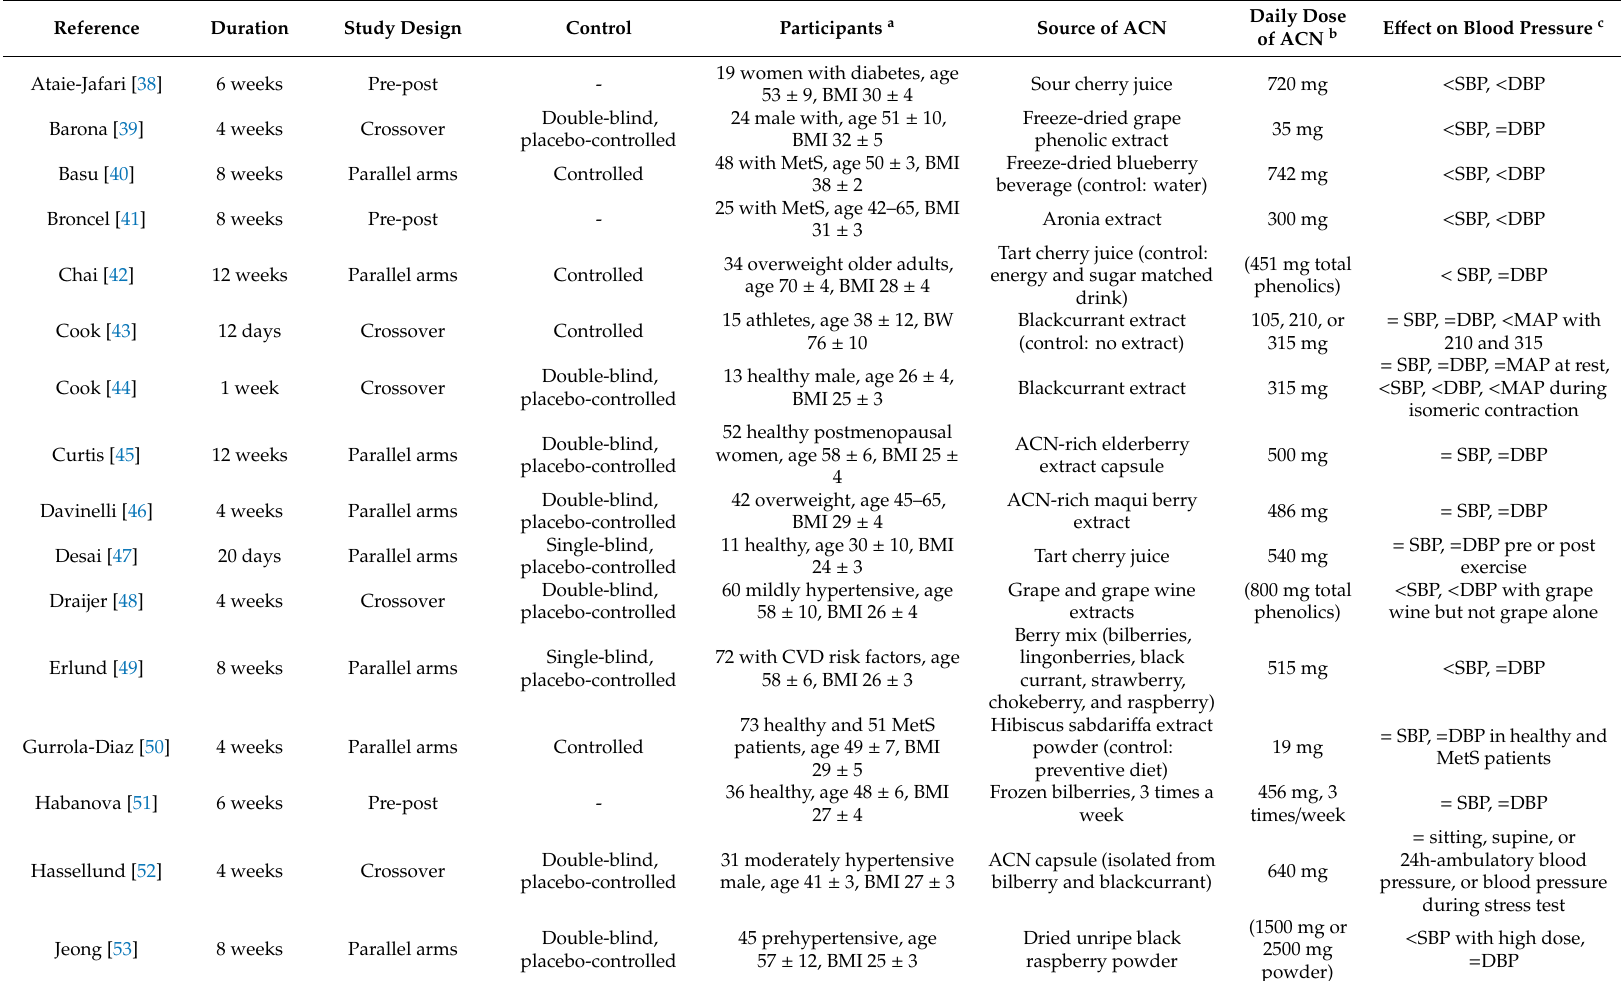
Table 2. Summary of long-term